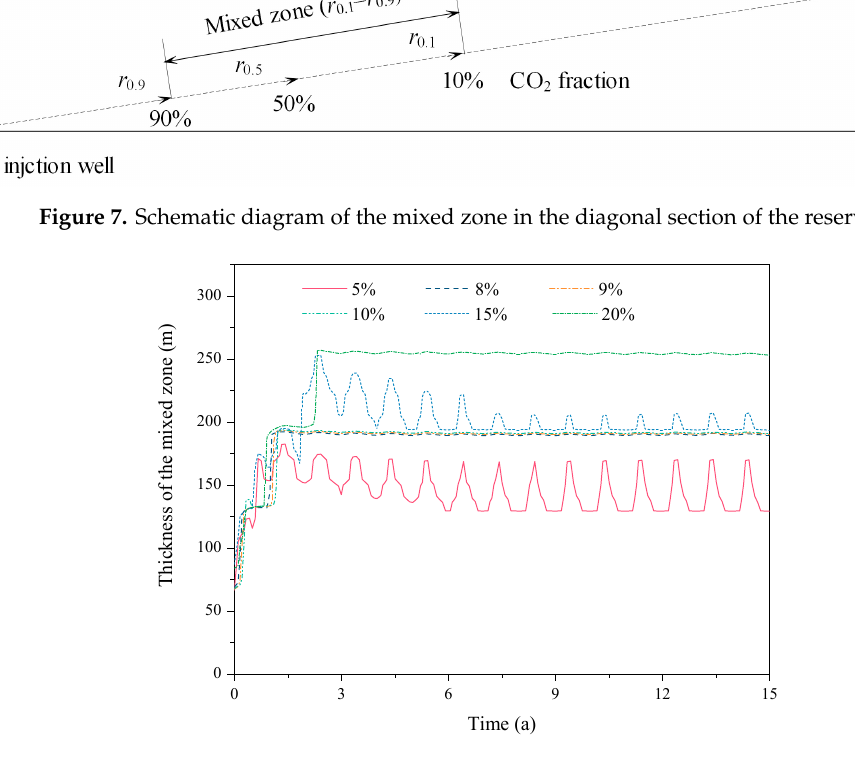
Figure 8. Thickness of the mixed zone for the UGSR with di ff erent concentration of CO 2 as cushion gas.